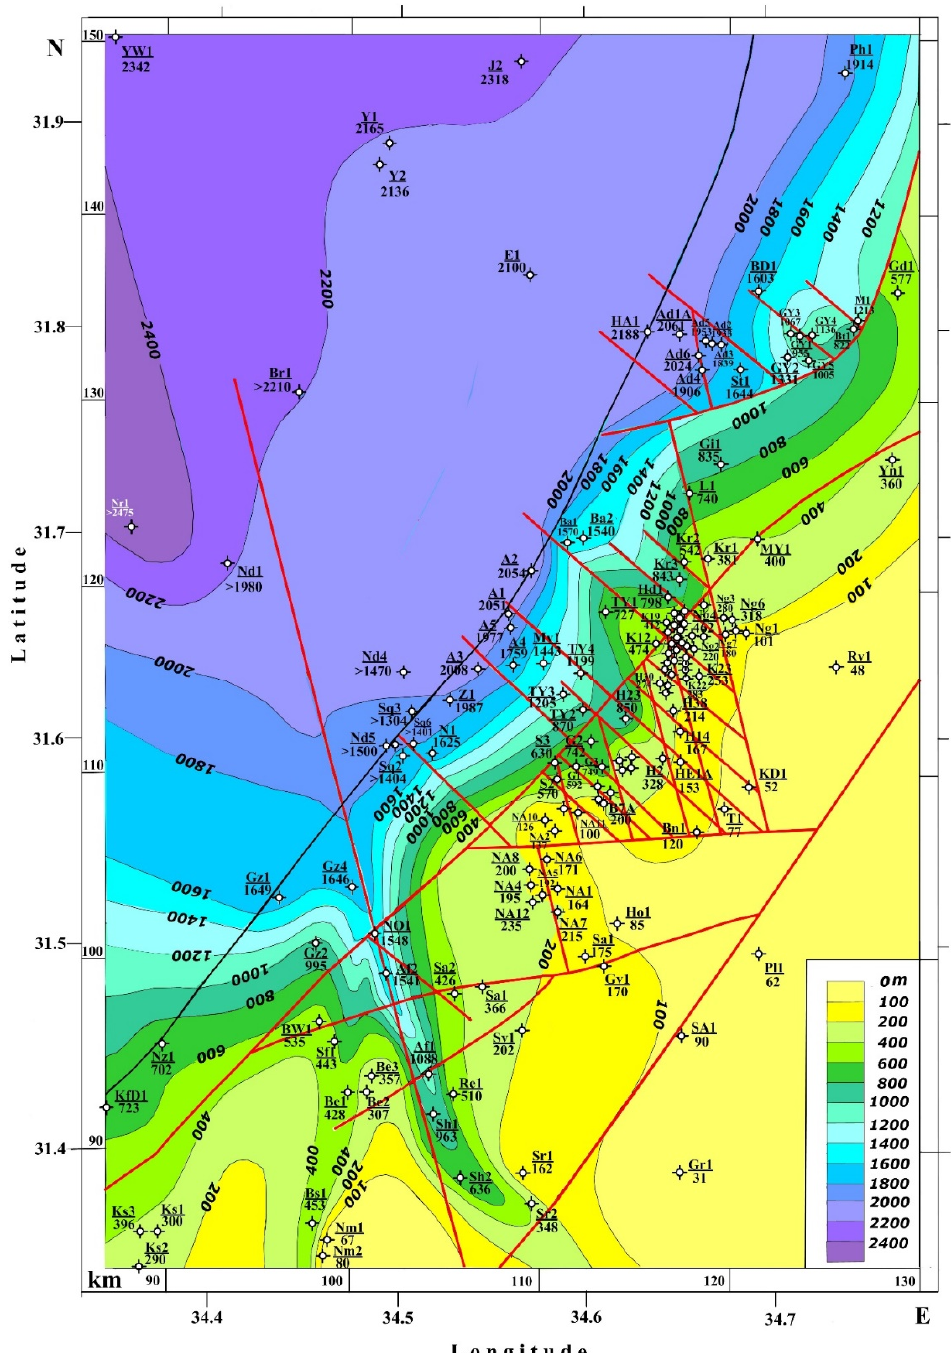
Figure 2. Neogene-Quaternary structural–paleogeographic map of the Heletz–Ashdod oil field and adjacent areas (isopach intervals are given in m). Borehole abbreviations: A, Ashkelon, Ad, Ashdod, Af, Afiq, B, Brur, Ba, Barnea, Be, Beeri, Bn, Binyamin, Br, Bravo, Bs, Bessor, Bt, Bitsaron, BD, Bene Darom, BW, Beeri West, E, Echo, G, Gevar Am, Gd, Gedera, Gi, Givati, Gr, Gerar, Gv, Gevim, Gz, Gaza, GY, Gan Yavne, H, Heletz, Hd, Hodiya, Ho, Hoga, HA, Hof Ashdod, HE, Heletz East, J, Joshua, K, Kokhav, Kr, Karmon, Ks, Kissufim, KD, King David, KfD, Kfar Darom, L, Lior, M, Mivtah, Mv, Mavkiim, MY, Massuot Yizhak, N, Nissanit, Nd, Nordan, Ng, Negba, Nm, Nirim, Nr, Nir, Nz, Nezarim, NA, Nir Am, NO, Nahal Oz, Ph, Palmahim, Pl, Pleshet, Rv, Revaha, S, Shimon,Sa, Saad, Sf, Sahaf, Sh, Shuva, Sq, Shiqma, Sr, Sharsheret, St, Shetulim, SA, Sedot Akiva, T, Telamim, TY, Talme Yafe, Y, Yam, Ya, Yakhini, Yn, YW, Yam West Yinnon, Z, Ziqim.